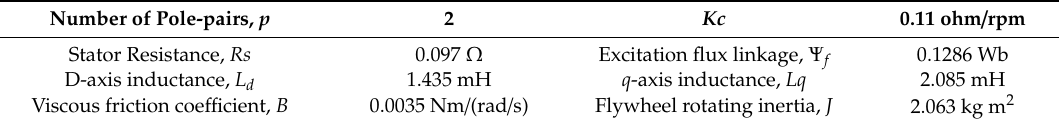
Table 2. Parameters of the Flywheel of the Permanent Magnet Synchronous Motor.